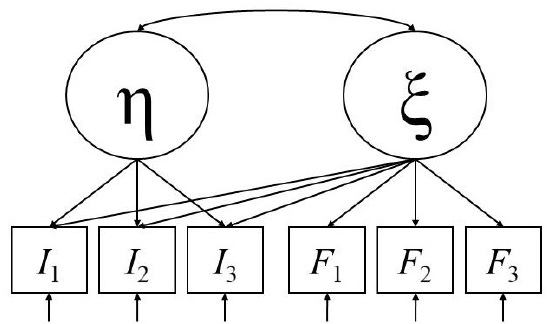
Figure 1. Anxiety test (AT) model as proposed by Halpin et al. [36]. A latent cognitive ability variable (η) is measured by its respective manifest test items (three in this example: I 1 , I 2 , and I 3 ). A latent anxiety variable (ξ) is measured by its respective manifest questionnaire items (again, three in this example: F 1 , F 2 , and F 3 ). The arrows approaching the manifest variables from below represent their respective error terms. Regressions of the ability test items on latent anxiety are also modeled and reflect interference effects. The correlation between ability and anxiety is modeled and represents a potential deficit. Simultaneous modeling of interferences and deficits creates statistical rotational indeterminacy, rendering the model under-identified. However, strategic equality constraints among the factor loading parameters (for example: all interference effects are restricted to the same value) solve this problem.